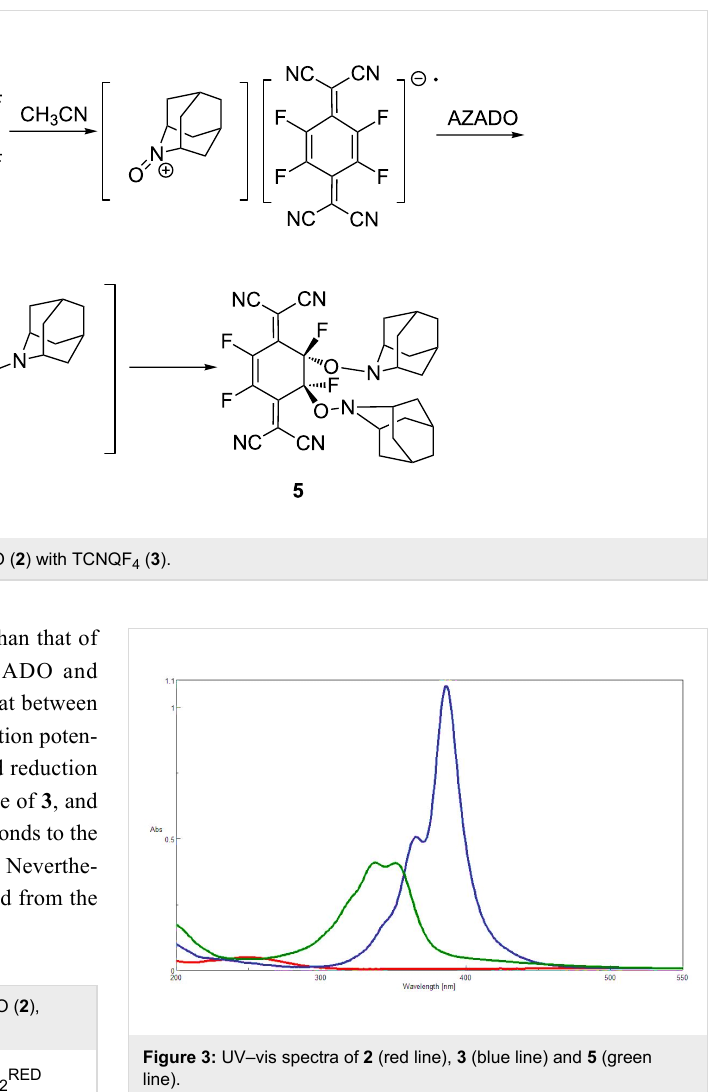
Structure of the reaction product of AZADO and